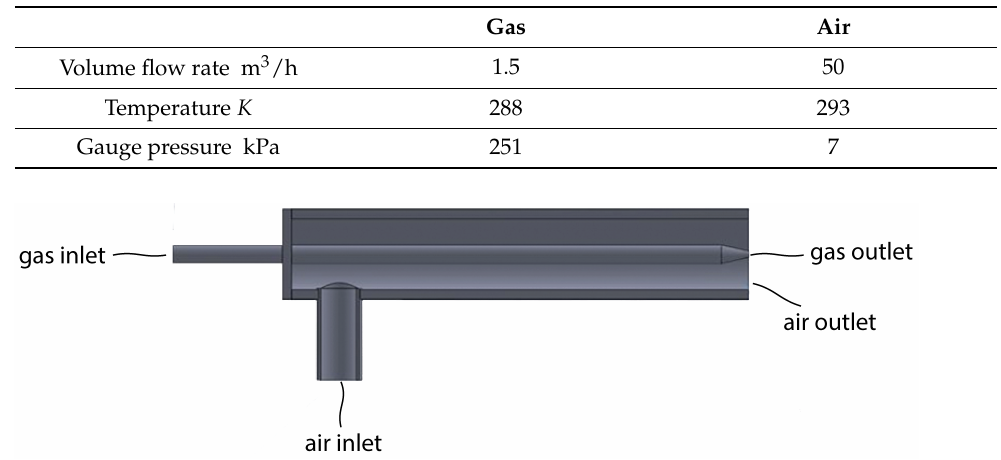
Figure 1. A typical gas burner model for a production of